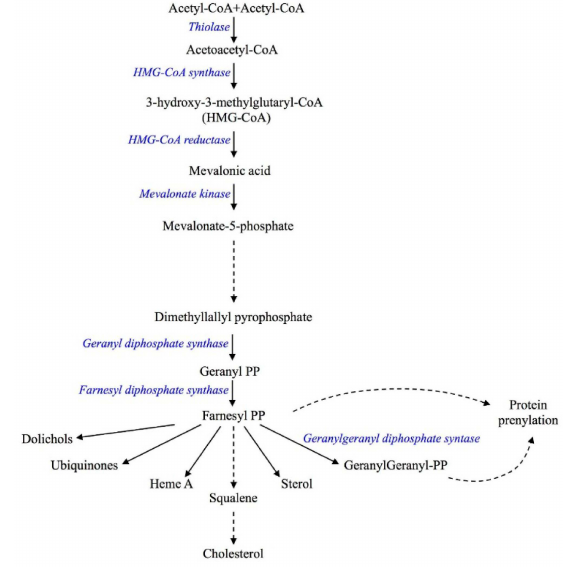
Figure 1. Schematic representation of the mevalonate pathway. The solid arrows represent the single enzymatic reaction while the dashed arrows indicate multiple reaction